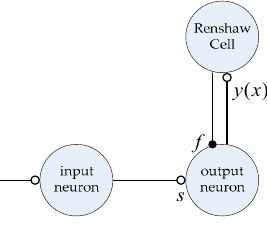
Figure 9. Equivalent model of the original neuron monomer model.